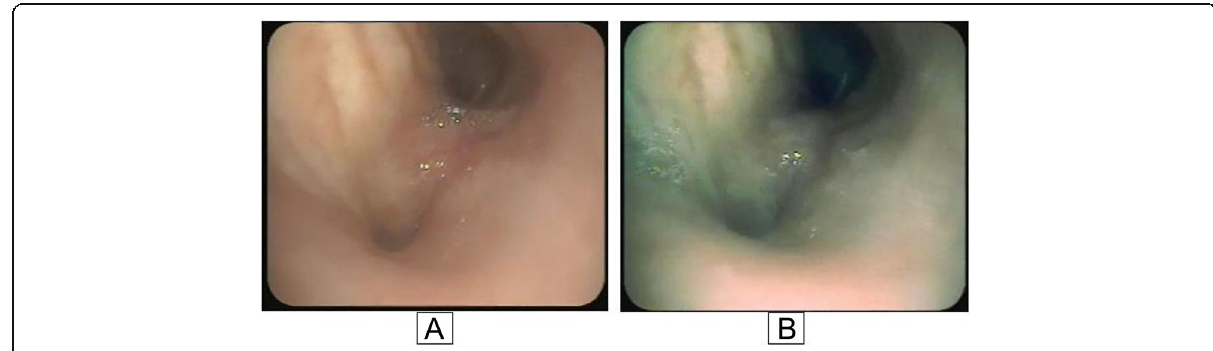
Table 2 Diagnosed histopathological types Squamous cell carcinoma 7 (46.7%) Adenocarcinoma